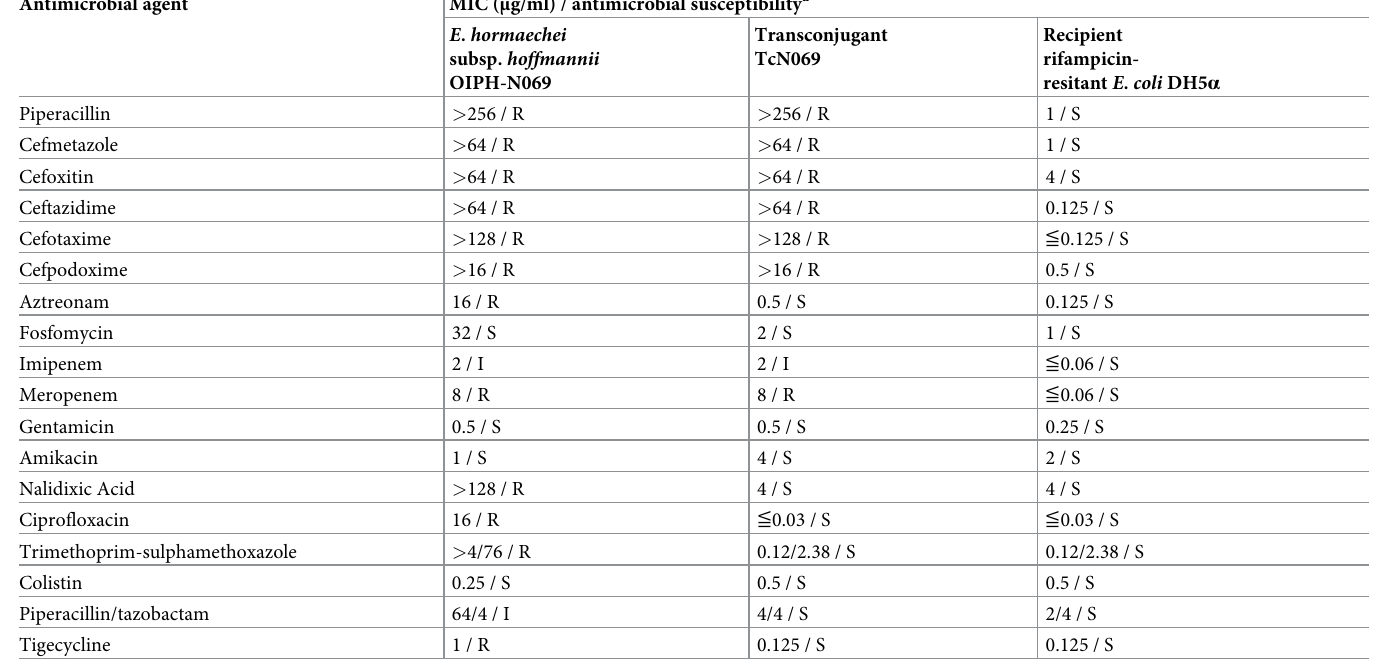
Table 1. Antibiotic susceptibility test